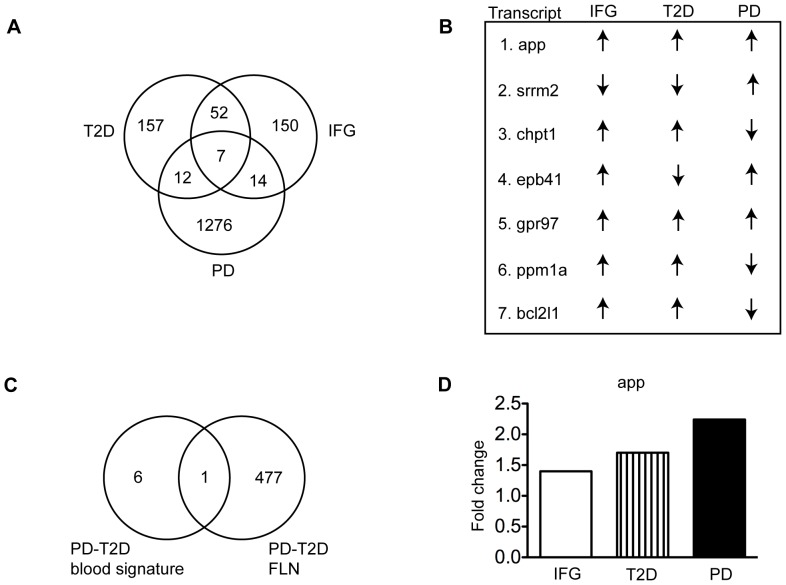
Identification of a blood signature of Parkinson's disease and type 2 diabetes.
A. Venn diagram analysis of gene expression data from pre-diabetes, type 2 diabetes and Parkinson's disease patients revealed seven genes common to all groups. B. Fold change direction for the seven genes signature identified in the microarrays studies. C. Venn diagram analysis of the seven genes dysregulated in blood of Parkinson's disease and type 2 diabetes compared to the Parkinson's disease-type 2 diabetes network. D. Fold change in mRNA expression of APP in microarray studies. PD  =  Parkinson's disease, IFG  =  pre-diabetes and T2D  =  type 2 diabetes.